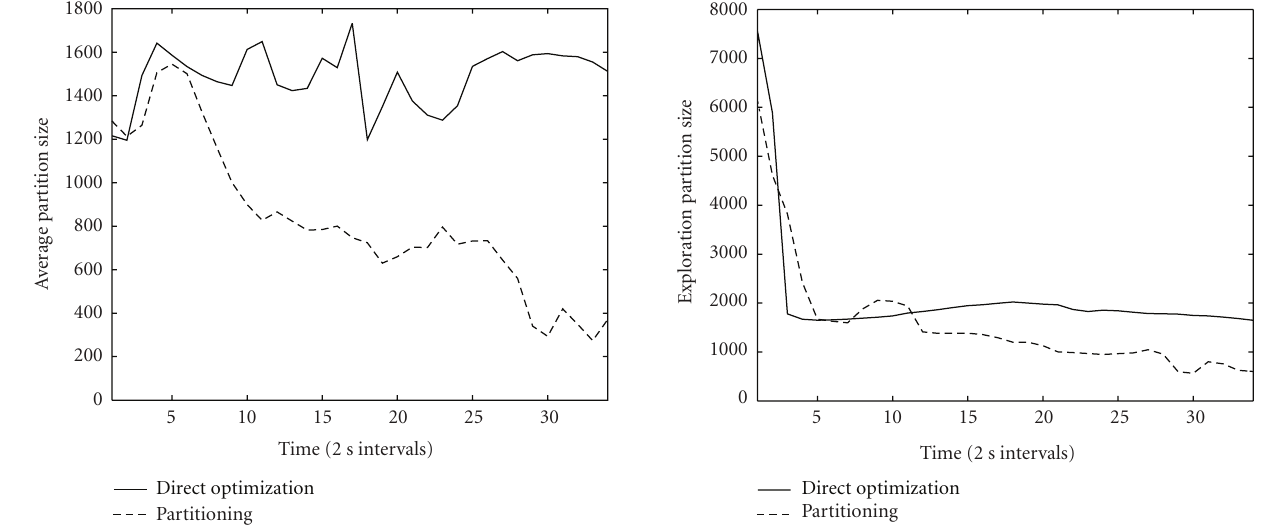
Figure 17: Comparison of sample mean average search and tracking partition size over simulation time between state-of-the- art direct distribution optimization and partition learning classif- ication path planning approaches.